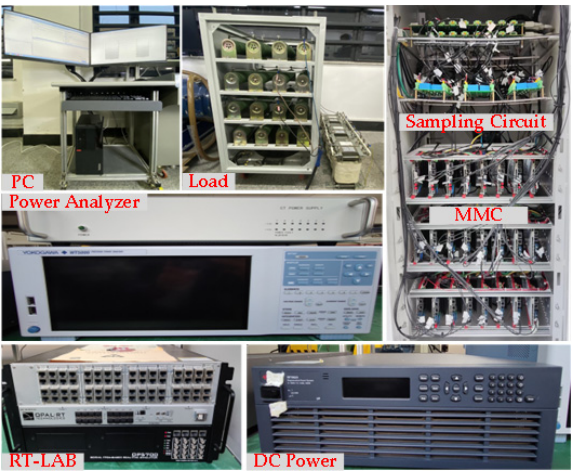
Figure 10. Five-level MMC experimental system. Table 5. Experimental